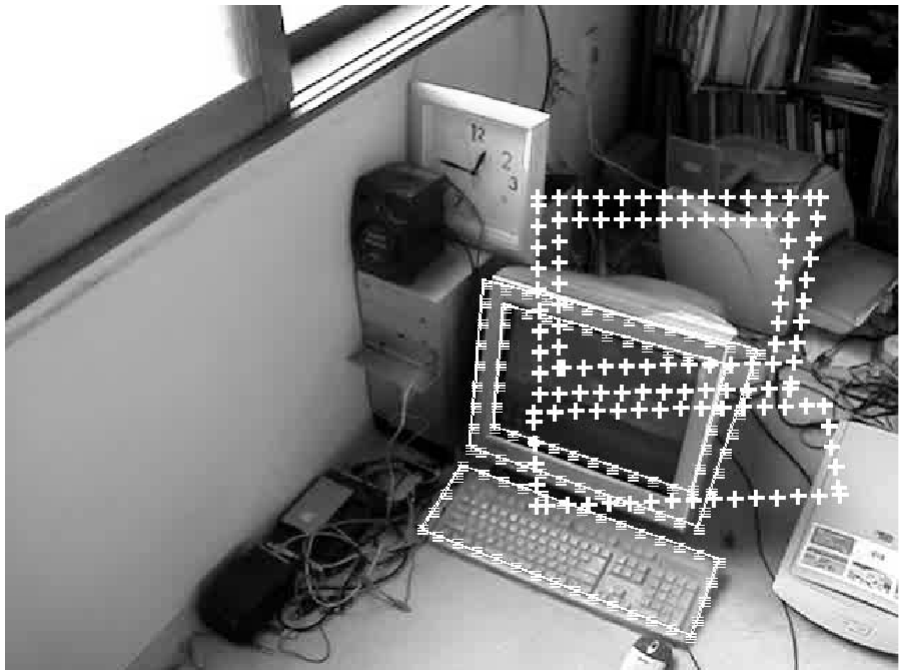
Figure 5. Conceptual comparison of the proposed method with contemporary methods. The leftmost picture is the given template. Areas to be used as indicators of comparison are marked with white highlight lines. In the target images given on the right, the area marked by the solid line (the proposed method) was deformed to match the target image, like the area marked by the triple line (brute-force method). On the other hand, the area indicated by the cross line (correlation method) was not deformed.